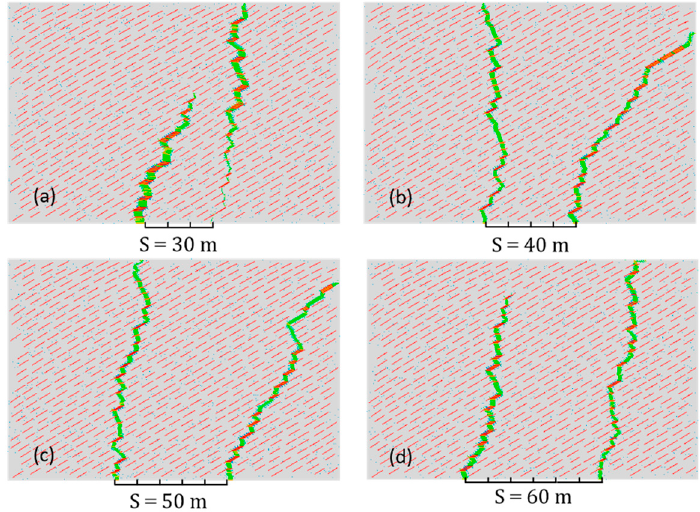
Figure 10. Effect of cluster spacing on hydraulic fracture propagation. ( a ) Cluster spacing = 30 m; ( b ) cluster spacing = 40 m; ( c ) cluster spacing = 50 m; ( d ) cluster spacing = 60 m.